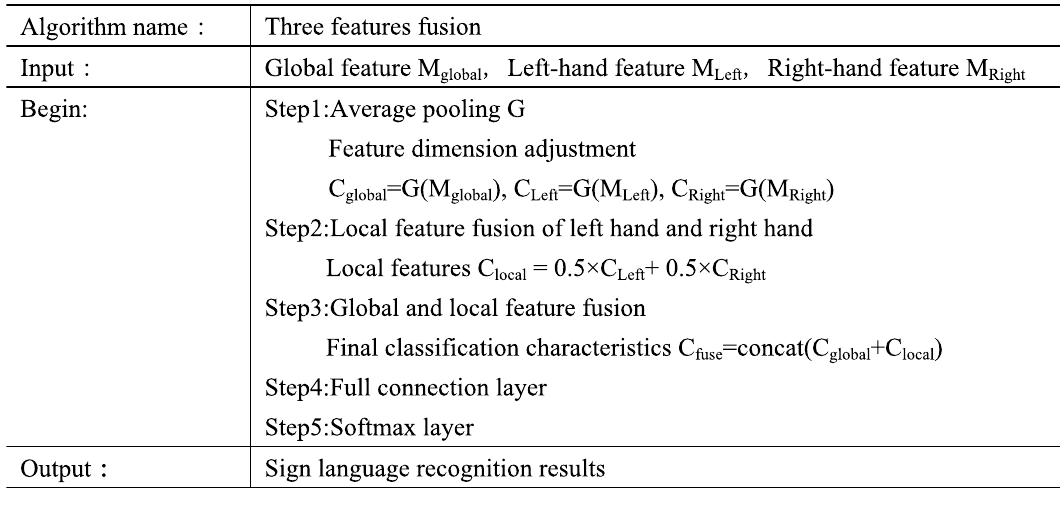
Figure 14. Pseudocode of three features fusion